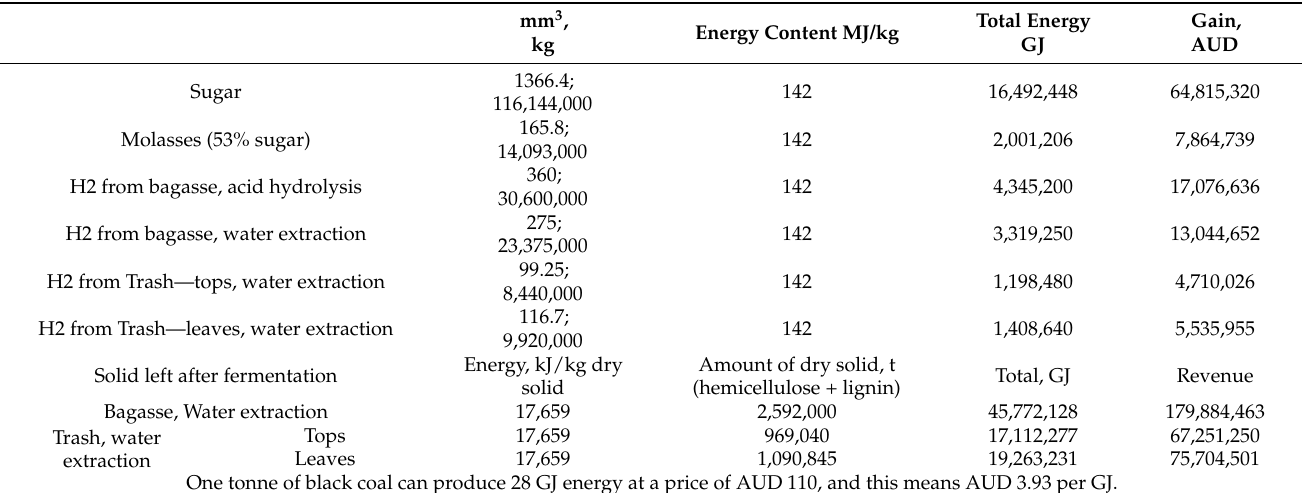
Table 21. Potential of hydrogen production from